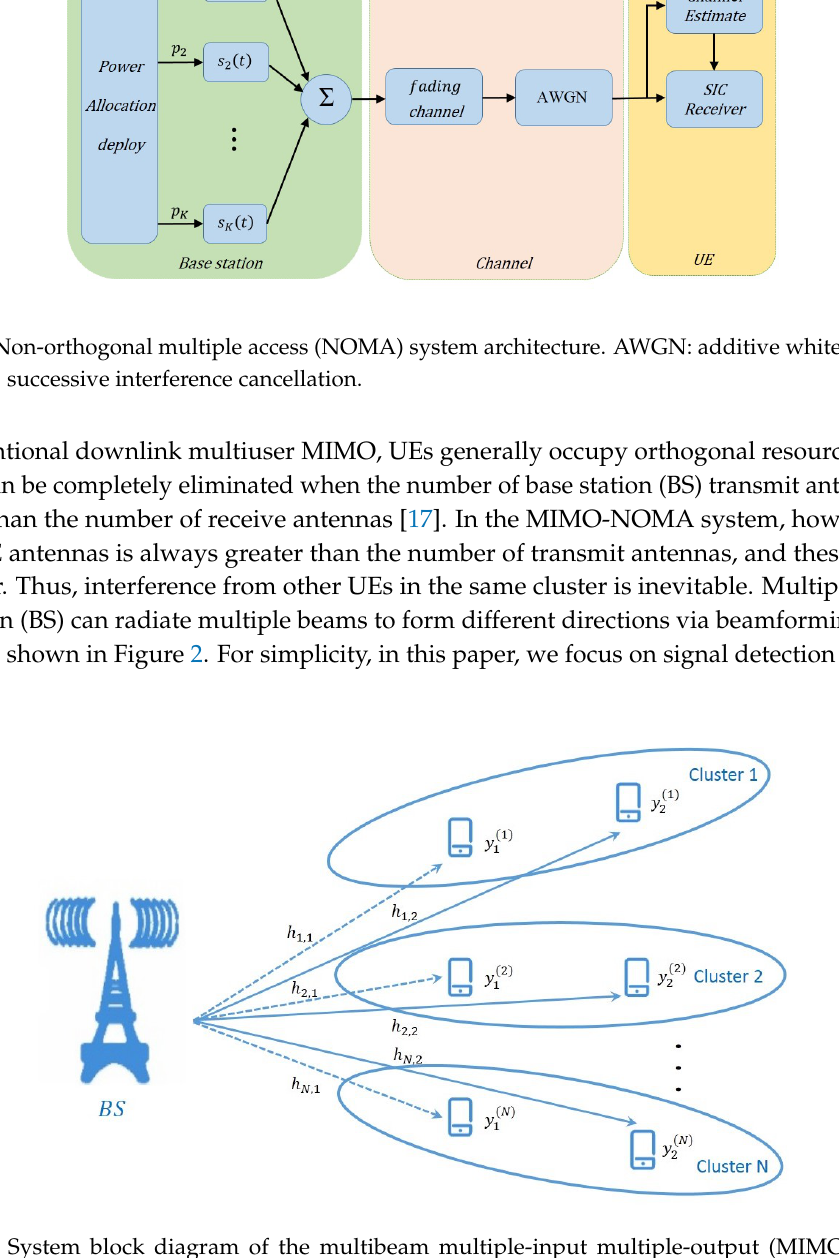
Figure 2. System block diagram of the multibeam multiple-input multiple-output (MIMO)-NOMA. BS: base